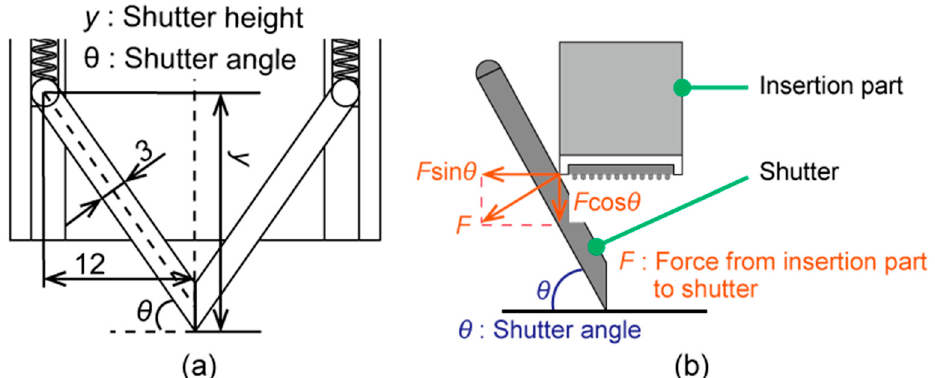
Figure 8. ( a ) The relationship among the parameters of the shutter. Shutter height y is obtained using geometry in terms of the shutter angle θ . ( b ) The simple model of the relationship between the forces that are related to opening the shutter.